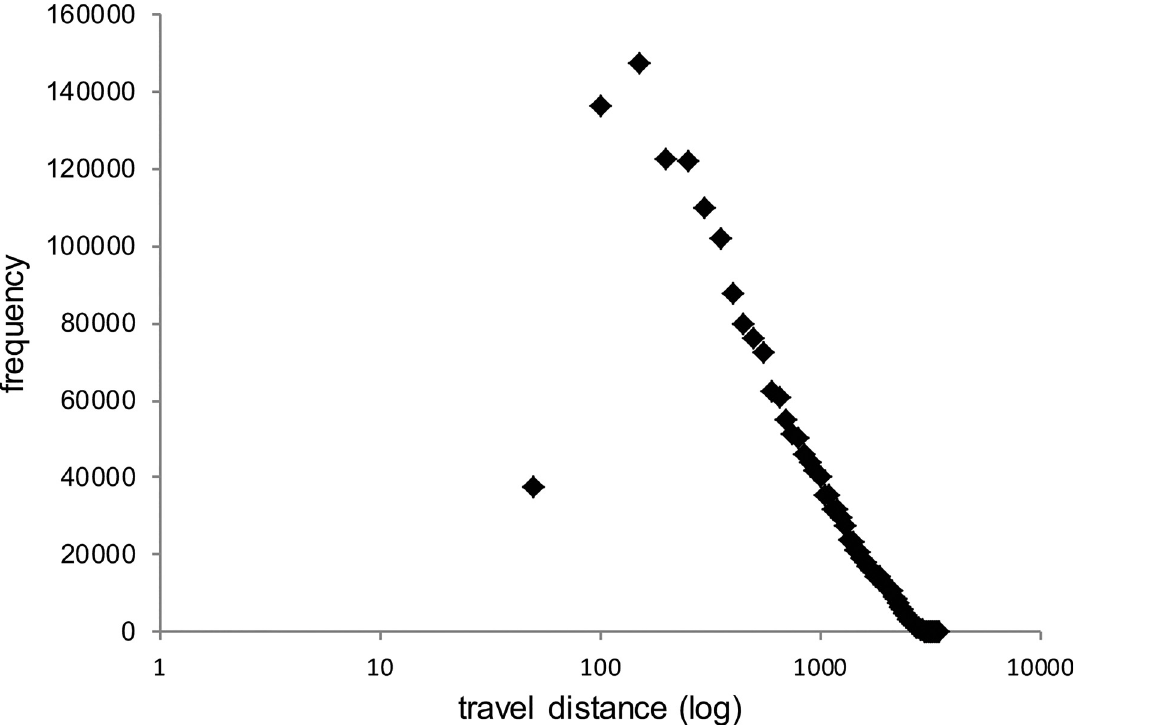
Fig 2. Frequency of distances for all the travels made during a month (model time) on semi-log scales.